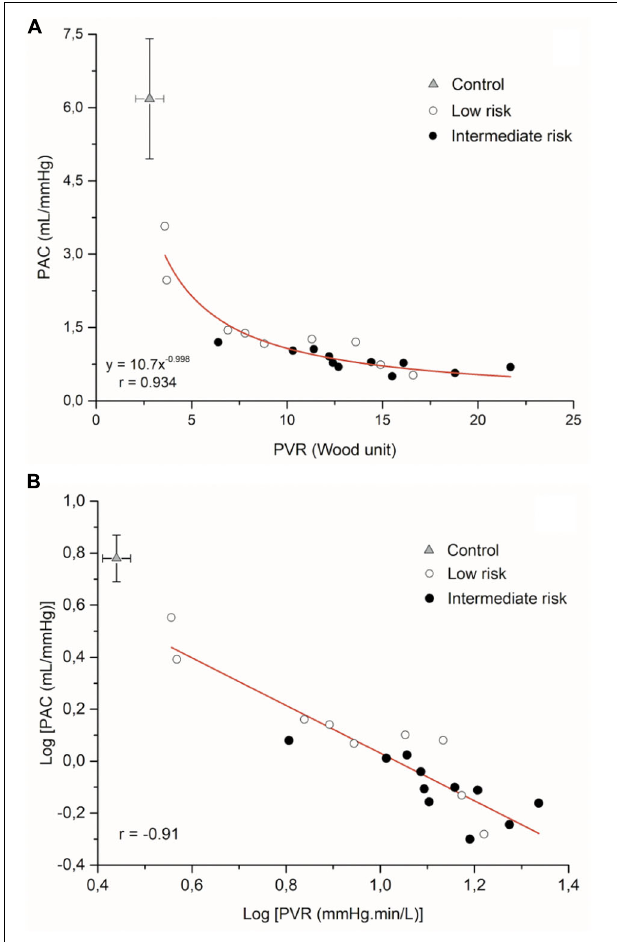
FIGURE 2 | (A) Inverse relationship of PVR-PAC relationship and (B) Log PVR-log PAC plot for all patients ( n = 9 low-risk patients; n = 11 intermediate-risk patients) (The PVR and PAC values of control patients are expressed by mean ± SD, n = 10). PAC, pulmonary arterial compliance; PVR, pulmonary vascular